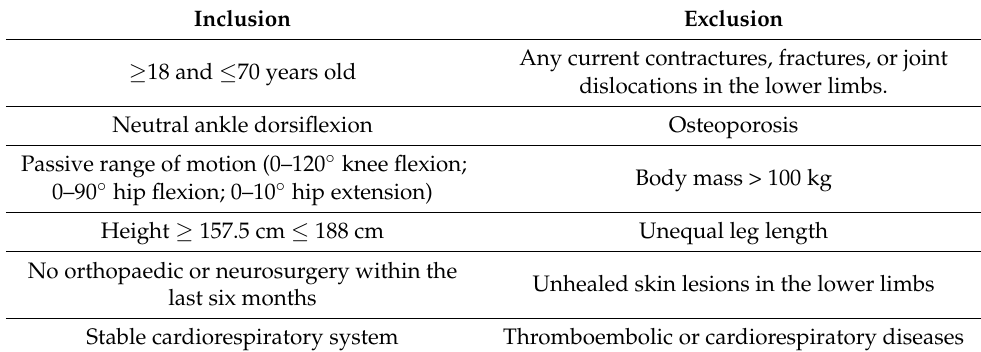
Table 1. Inclusion and exclusion criteria.